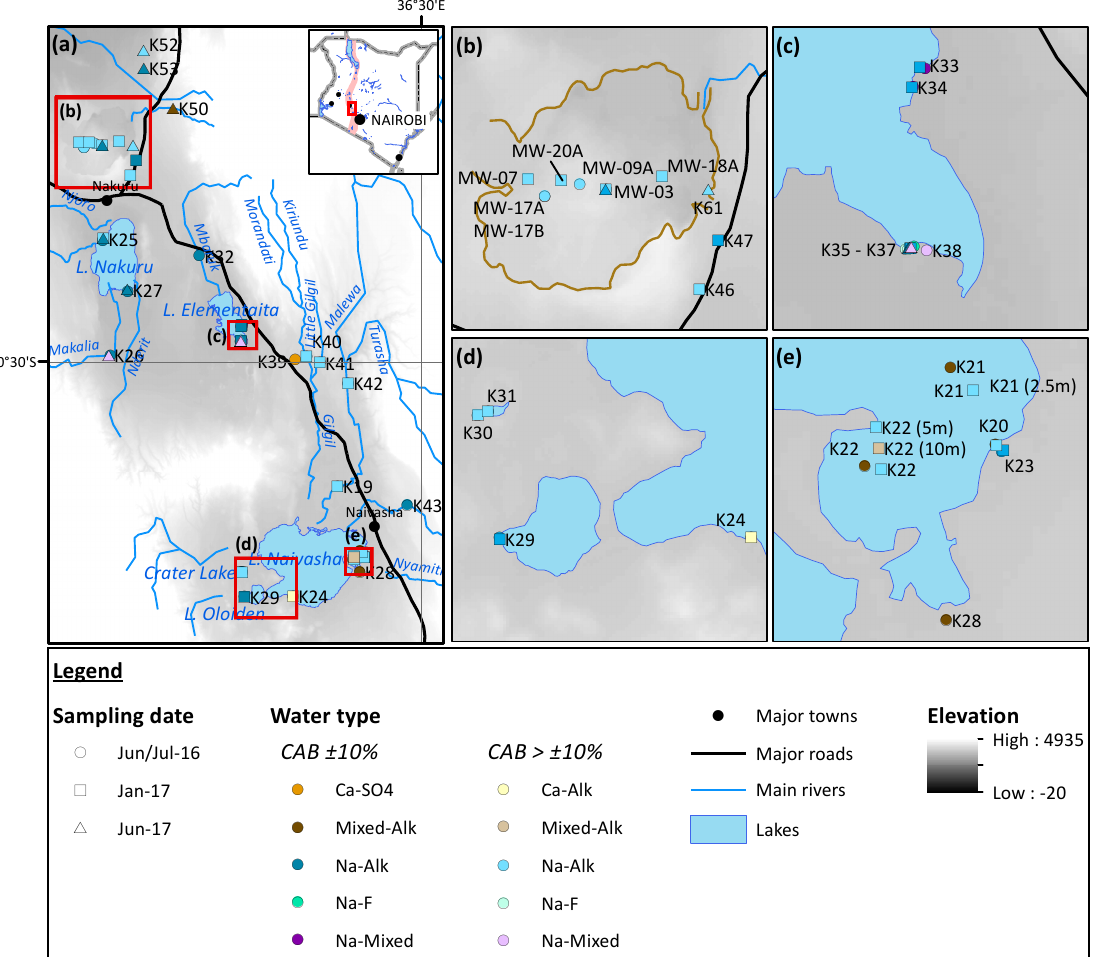
Figure 5. Fluid water type. ( a ) Entire study area; ( b ) Menengai Caldera; ( c ) southeast shore of Lake Elementaita; ( d ) southwest shore of Lake Naivasha, Lake Oloiden and Crater Lake; ( e ) east shore of Lake Naivasha. CAB: cation-anion